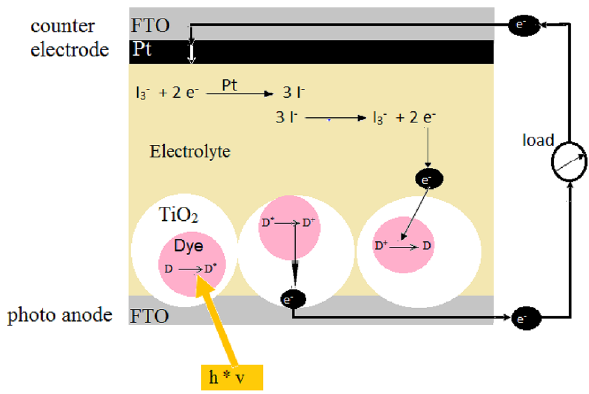
Fig. 2 Schematic illustration of a dye sensitized solar cell. The photo- anode and counter-electrode are based on glass coated with fluorine- doped tin oxide (FTO). The illumination ( h × v ) of a dye sensitized solar cell initiates a cascade of reactions leading to an electrical cur- rent. Photons excite the ground-state (D) dye molecule to its electron- ically excited (D*) state. The electronically excited dye molecule then injects an electron (e−) into the TiO 2 semiconductor conductive band and becomes an oxidized dye (D+) which will be reduced by iodide ( I − ) in the